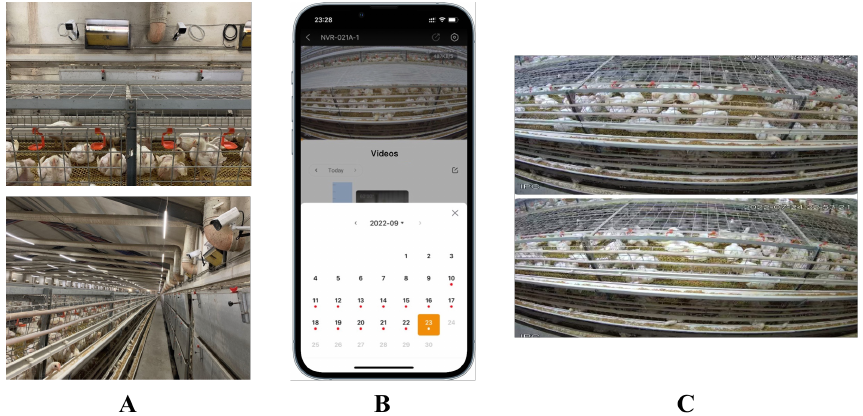
Figure 12. Intelligent system of chicken coop based on the model of this paper. ( A ): HD camera in the chicken coop; ( B ): app for accessing video stream; ( C ): video stream display.